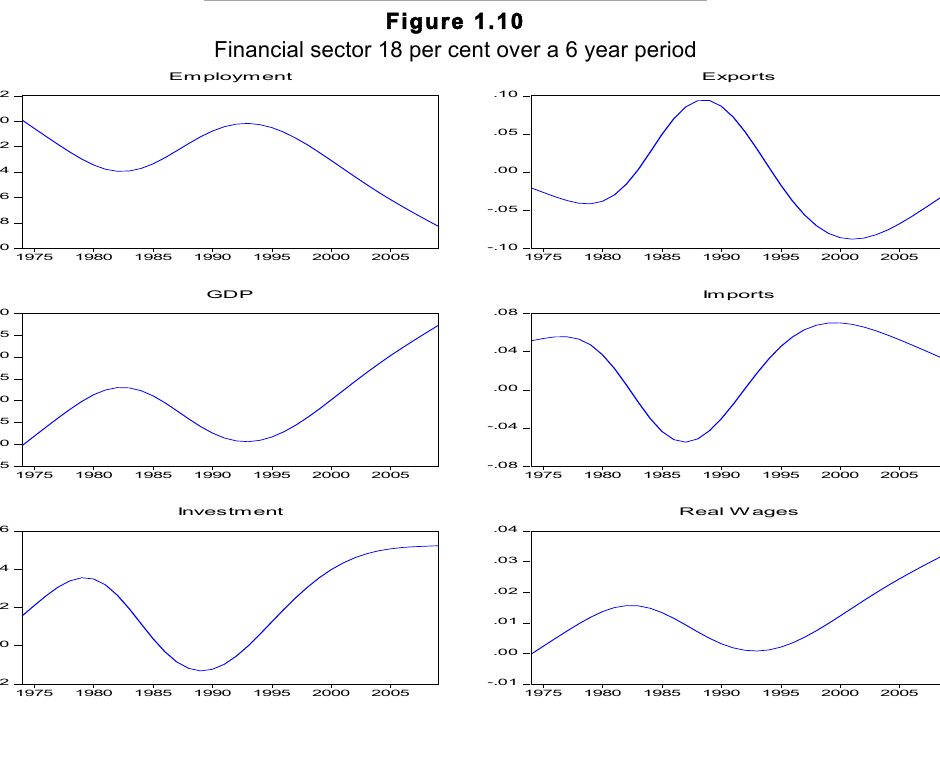
Figure 1.10 Financial sector 18 per cent over a 6 year period